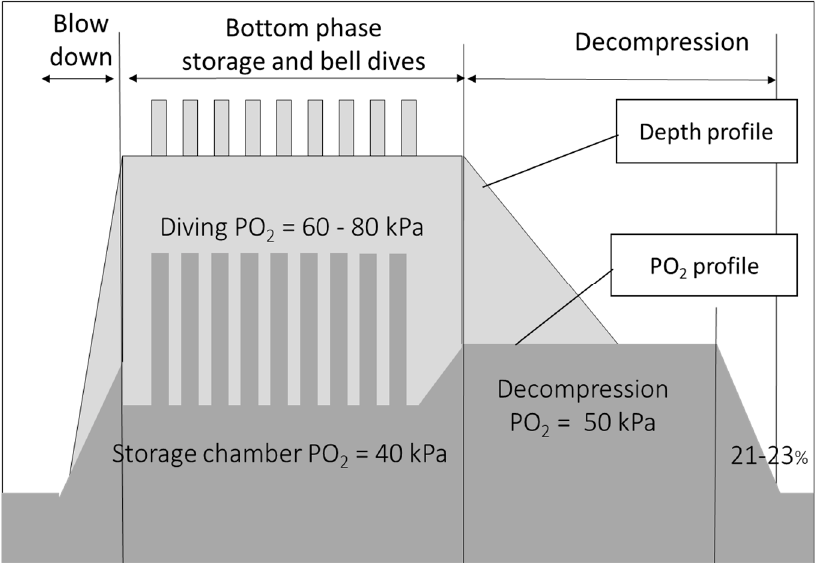
Figure 2. Description of the saturation in the UK sector: depth profile (compression, storage depth, bell dives, decompression) and associated PO 2 profile.